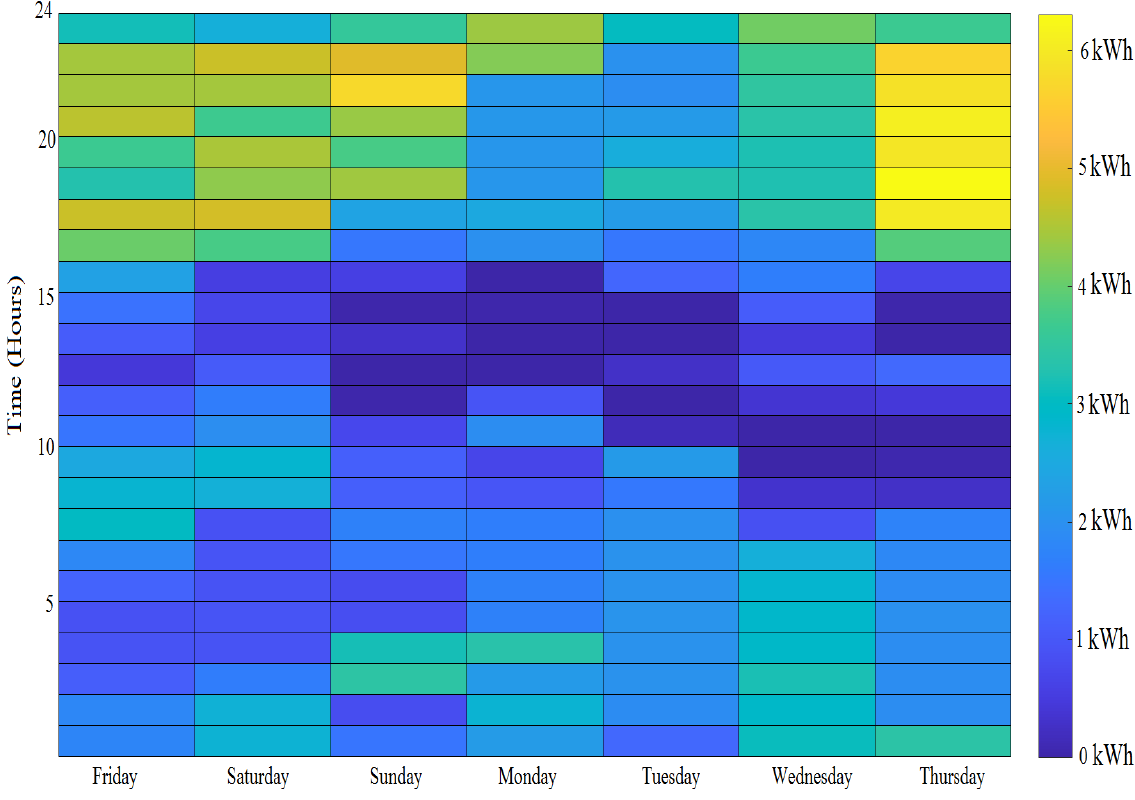
Figure 13. Breakdown of hourly demand distribution by day type.